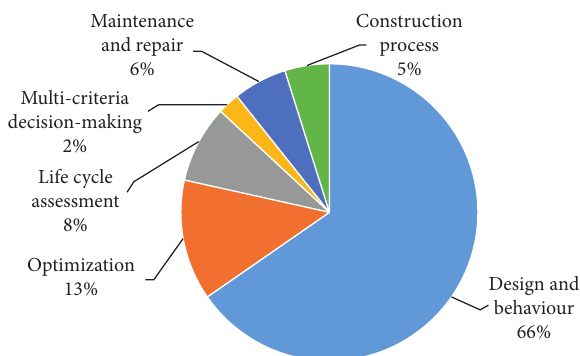
Figure 3: Distribution of publications in every research